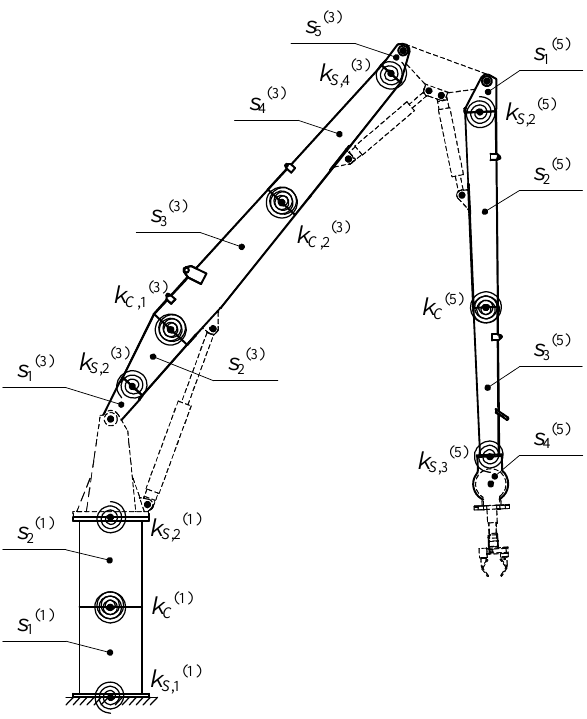
Figure 6: Segmentations of flexible